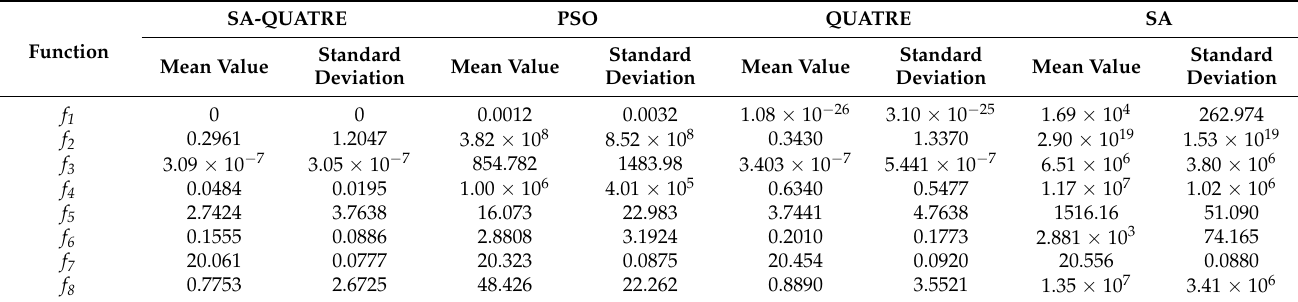
Table 2. Results of eight general benchmark functions.